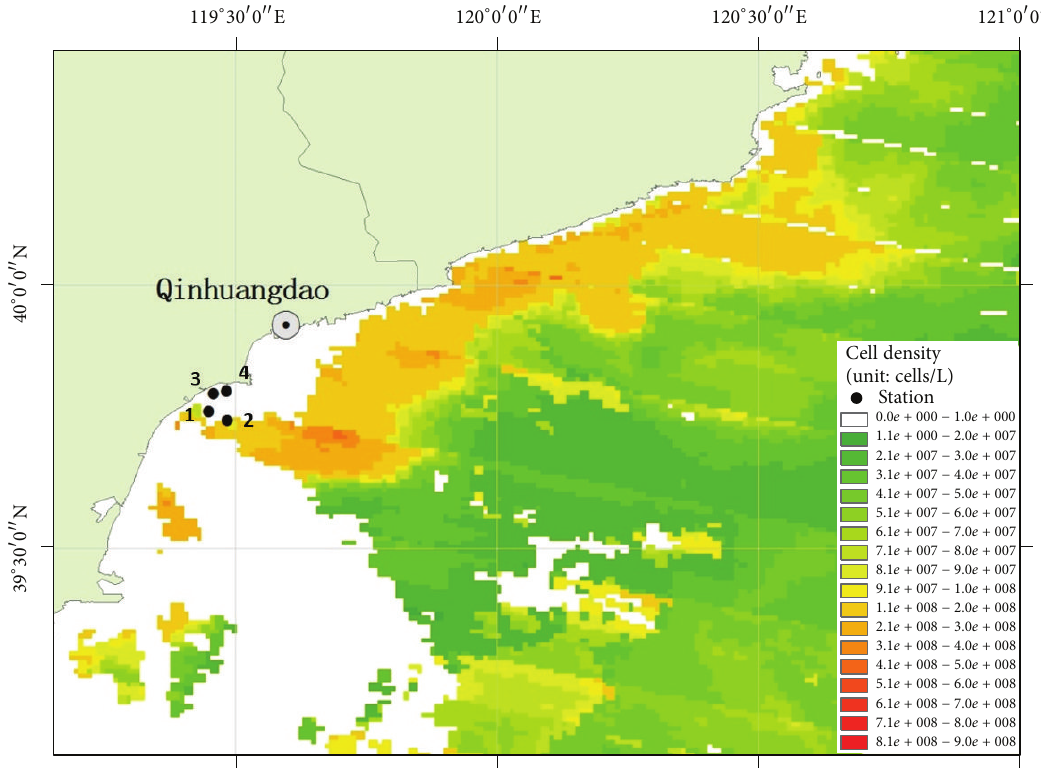
Figure 8: Cell density distribution of using single-band inversion model.